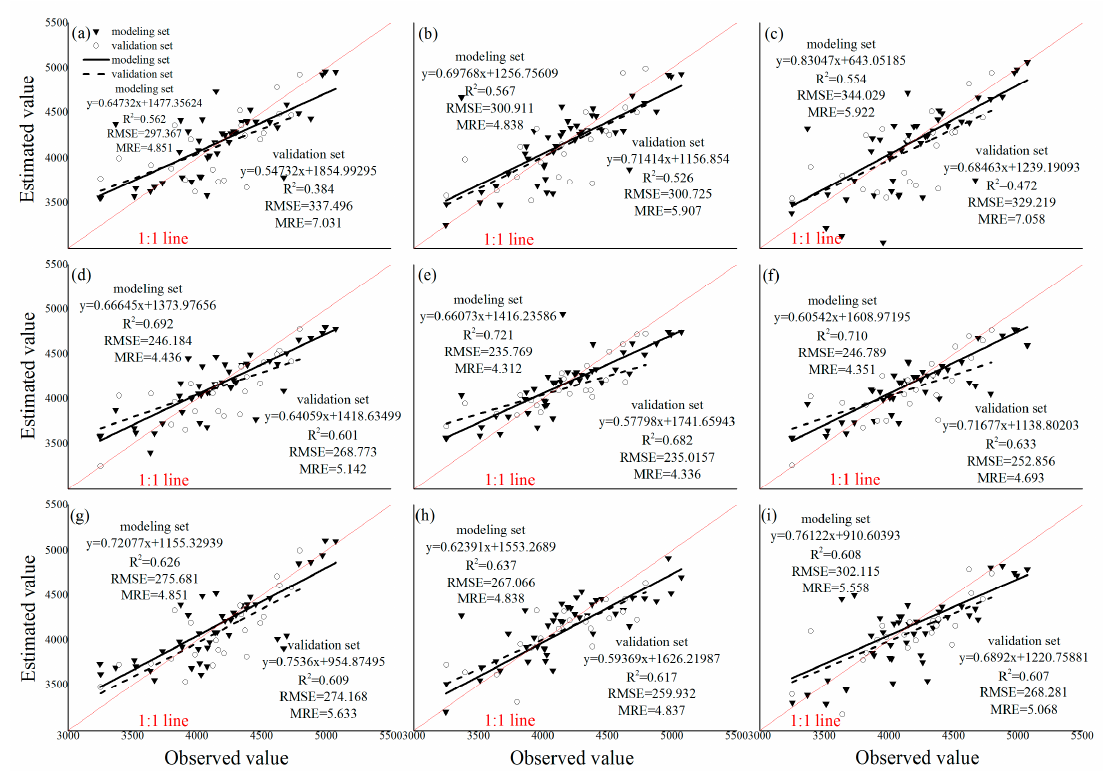
Figure 6. Prediction results of modeling set and validation set of winter wheat above-ground biomass inversion model with different input variables and modeling methods ( a ) SVM Model input variable is combination 1; ( b ) SVM Model input variable is combination 2; ( c ) SVM Model input variable is combination 3; ( d ) RF Model input variable is combination 1; ( e ) RF Model input variable is combination 2; ( f ) RF Model input variable is combination 3; ( g ) BPNN Model input variable is combination 1; ( h ) BPNN Model input variable is combination 2; ( i ) BPNN Model input variable is combination 3.